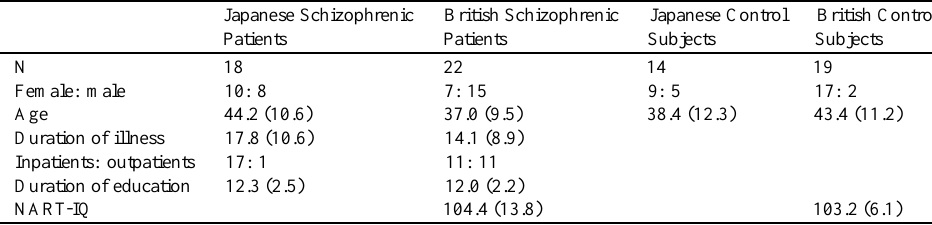
Table 1 Demographic and baseline variables of the Japanese schizophrenic patients, the British schizophrenic patients, and the Japanese and British healthy control subjects (means and, in parenthesis, standard deviations for age, duration of illness, duration of education, and NART-IQ)